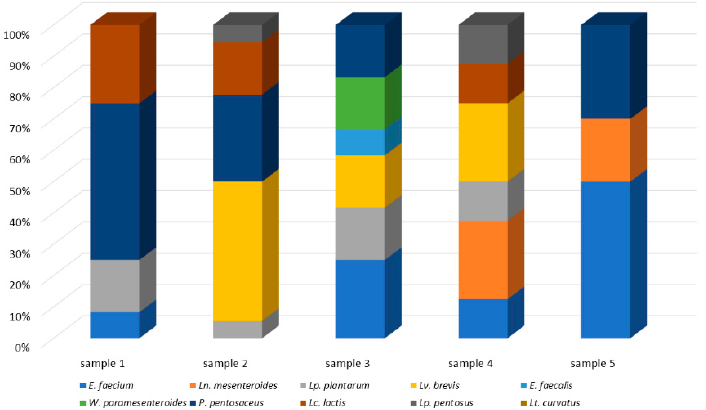
Figure 3. The microecosystem of the five sheep’s milk samples that were analyzed in the present study.